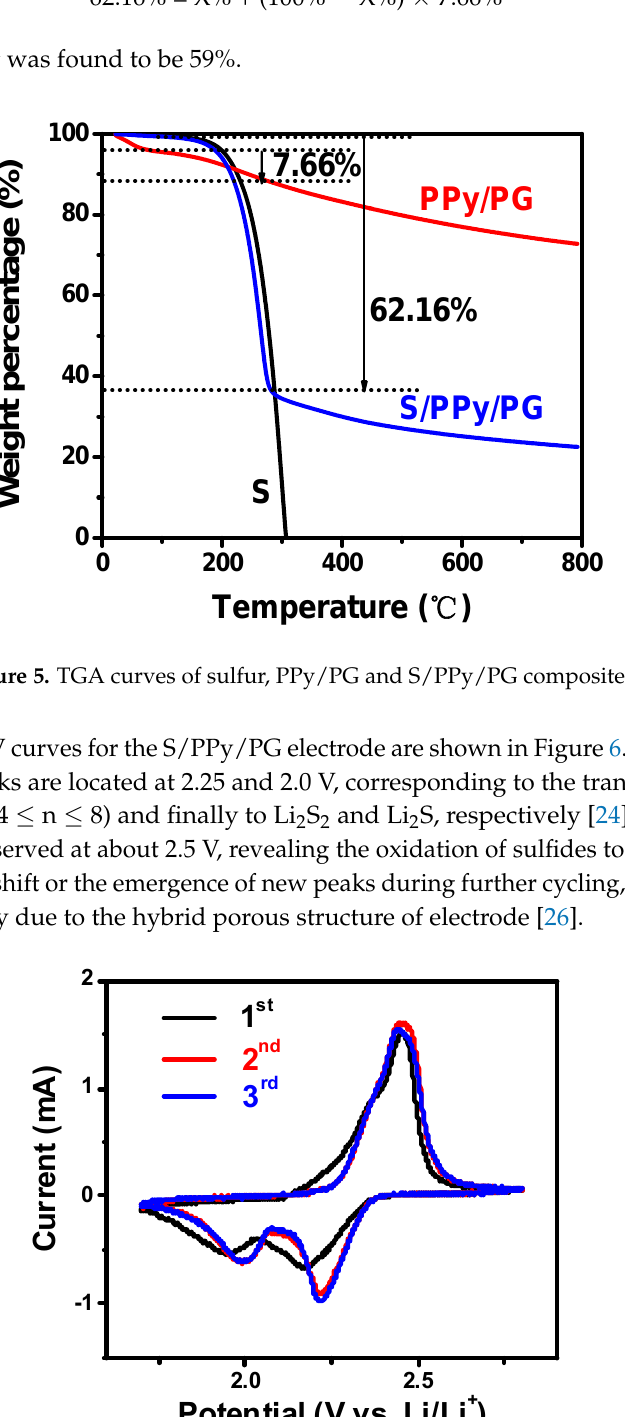
Figure 6. Initial three CV curves of S/PPy/PG composite electrode at a scan rate of 0.1 mV s − 1 .